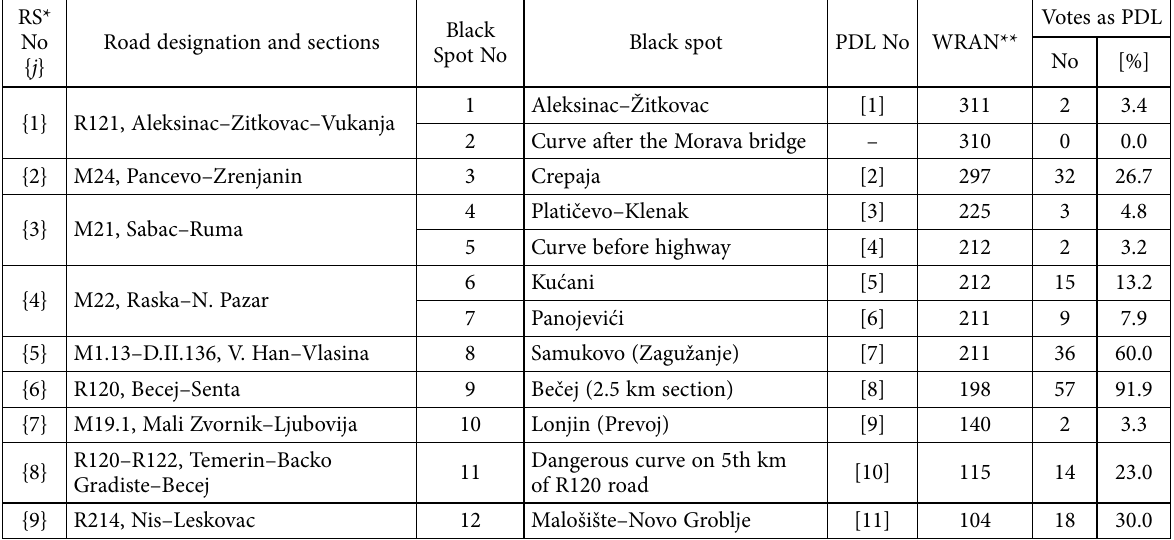
Table 3. The overview of main data on Black Spots and